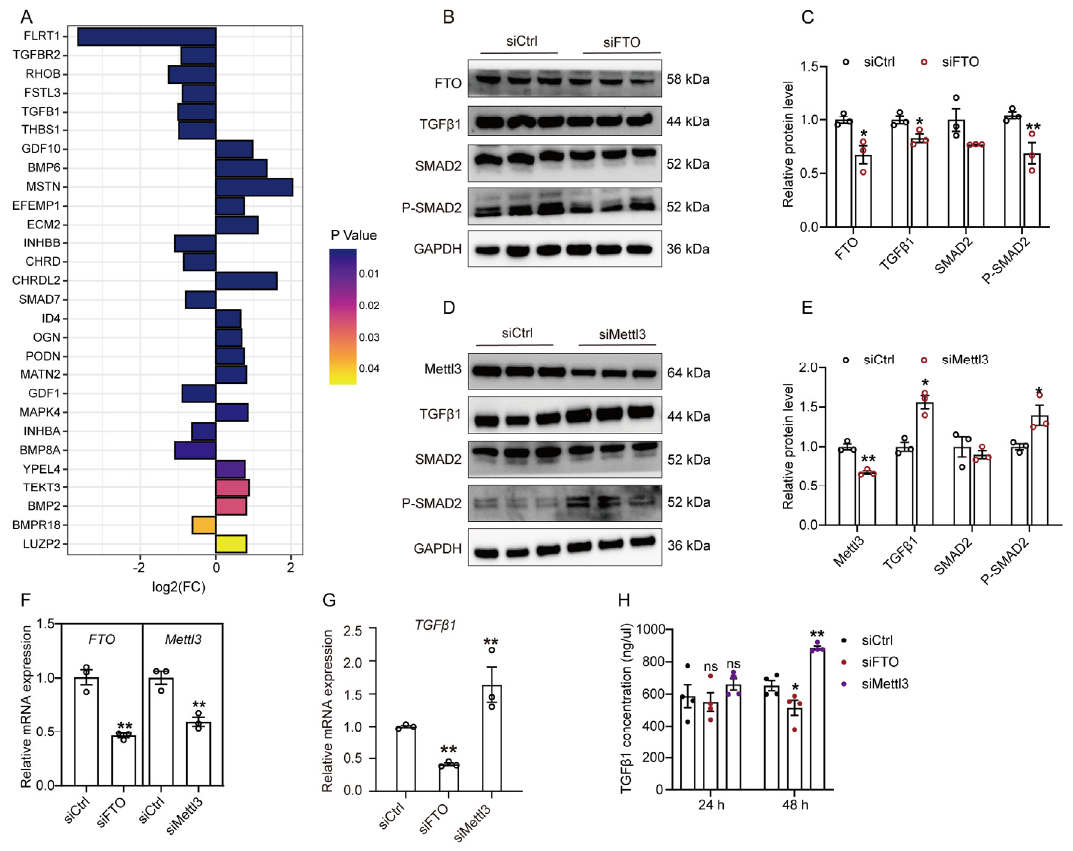
Figure 4 . m 6 A regulates the TGF β 1-mediated SMAD2 signaling pathway: ( A ) The transcript abundance of the TGF β pathway-related genes in differentially expressed genes between cells transfected with siCtrl and FTO siRNA (siFTO); ( B – E ) GPMs were treated with siFTO or Mettl3 siRNA (siMettl3); ( B , D ) The protein levels of TGF β 1, SMAD2, P-SMAD2 were measured at post-transfection 48 h; ( C , E ) Quantification of Western blots in B and D; ( F ) GPMs were treated with siFTO or Mettl3 siRNA (siMettl3), and the mRNA expression of TGF β 1 ( G ) was measured at 36 h; ( H ) After transfection for 24 h and 48 h, TGF β 1 concentration in culture medium of GPMs was measured using ELISA. The data were obtained from at least three independent experiments. Results are expressed as mean ± SEM; * p < 0.05, ** p < 0.01, ns indicates p >